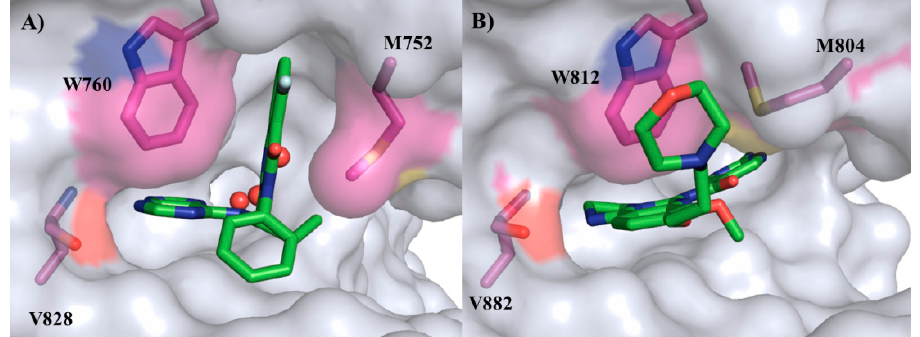
Figure 3. Binding modes of idelalisib ( 1 ) in PI3K δ (PDB:4XE0) ( A ) and copanlisib ( 2 ) in PI3K γ (PDB:5G2N) ( B ).